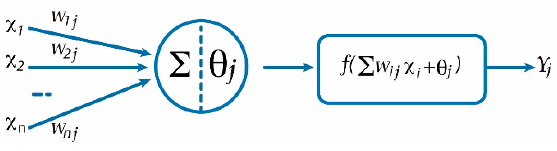
Figure 4. Artificial neuron model.